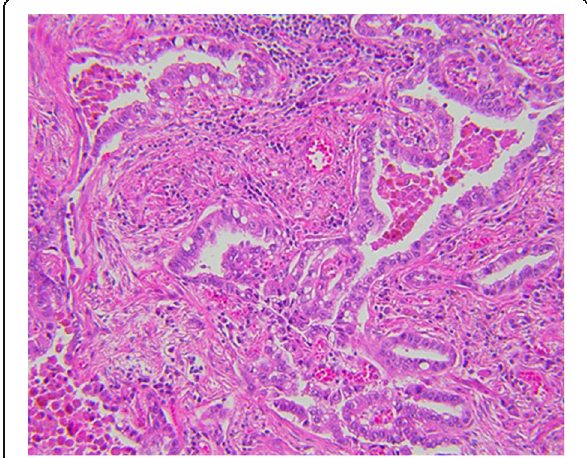
Fig. 5 MIA histopathology: focal invasive growth < 5 mm diameter